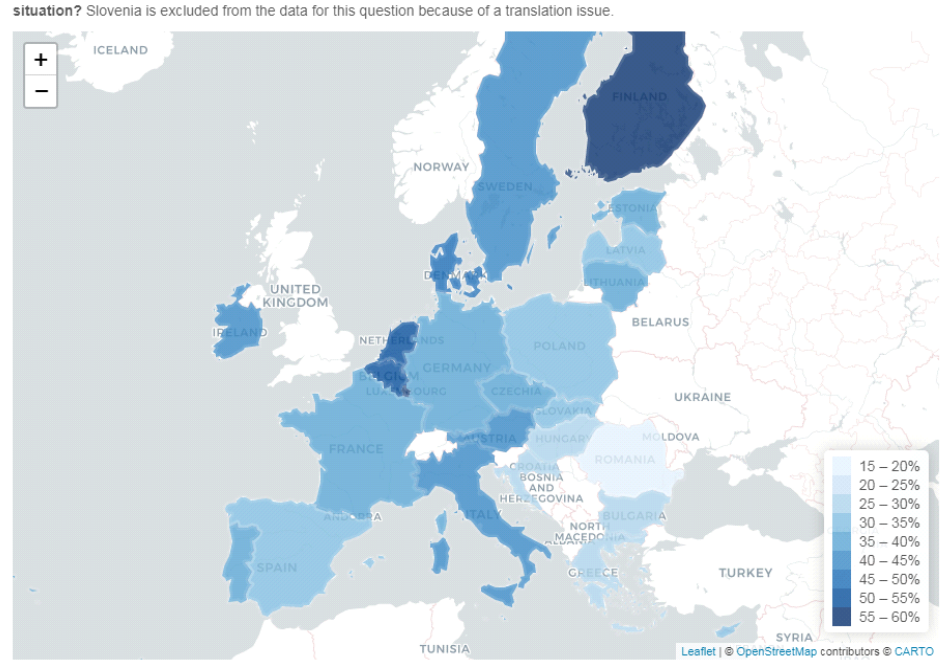
Figure 1. Teleworking in Europe as a result of the coronavirus crisis.